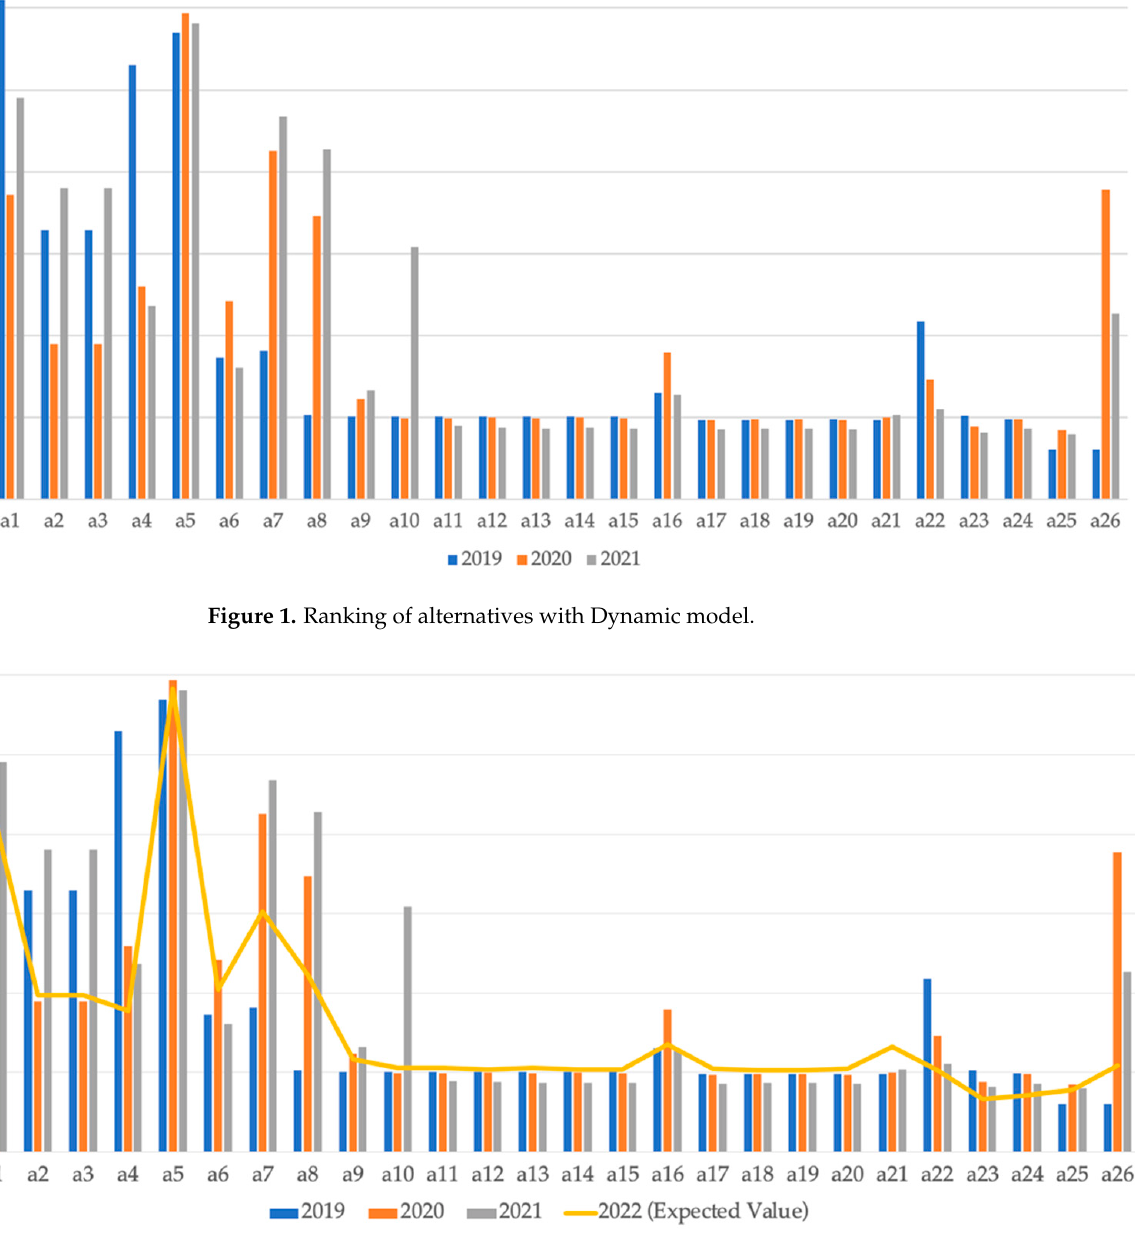
Figure 2. Comparison of alternatives ranking among a dynamic and prospective approach.